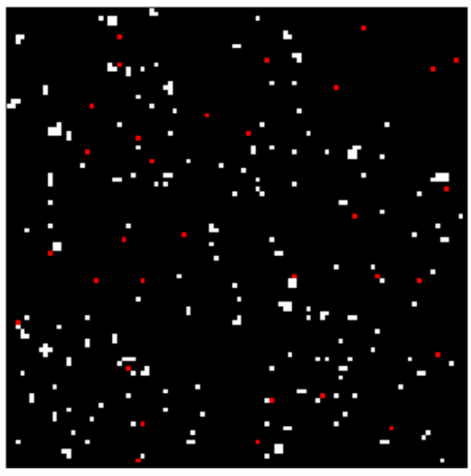
Figure 11. Color-coded chemical image of Sudan-I and metanil yellow generated by contribution images. White pixels represent Sudan-I and red pixels represent metanil